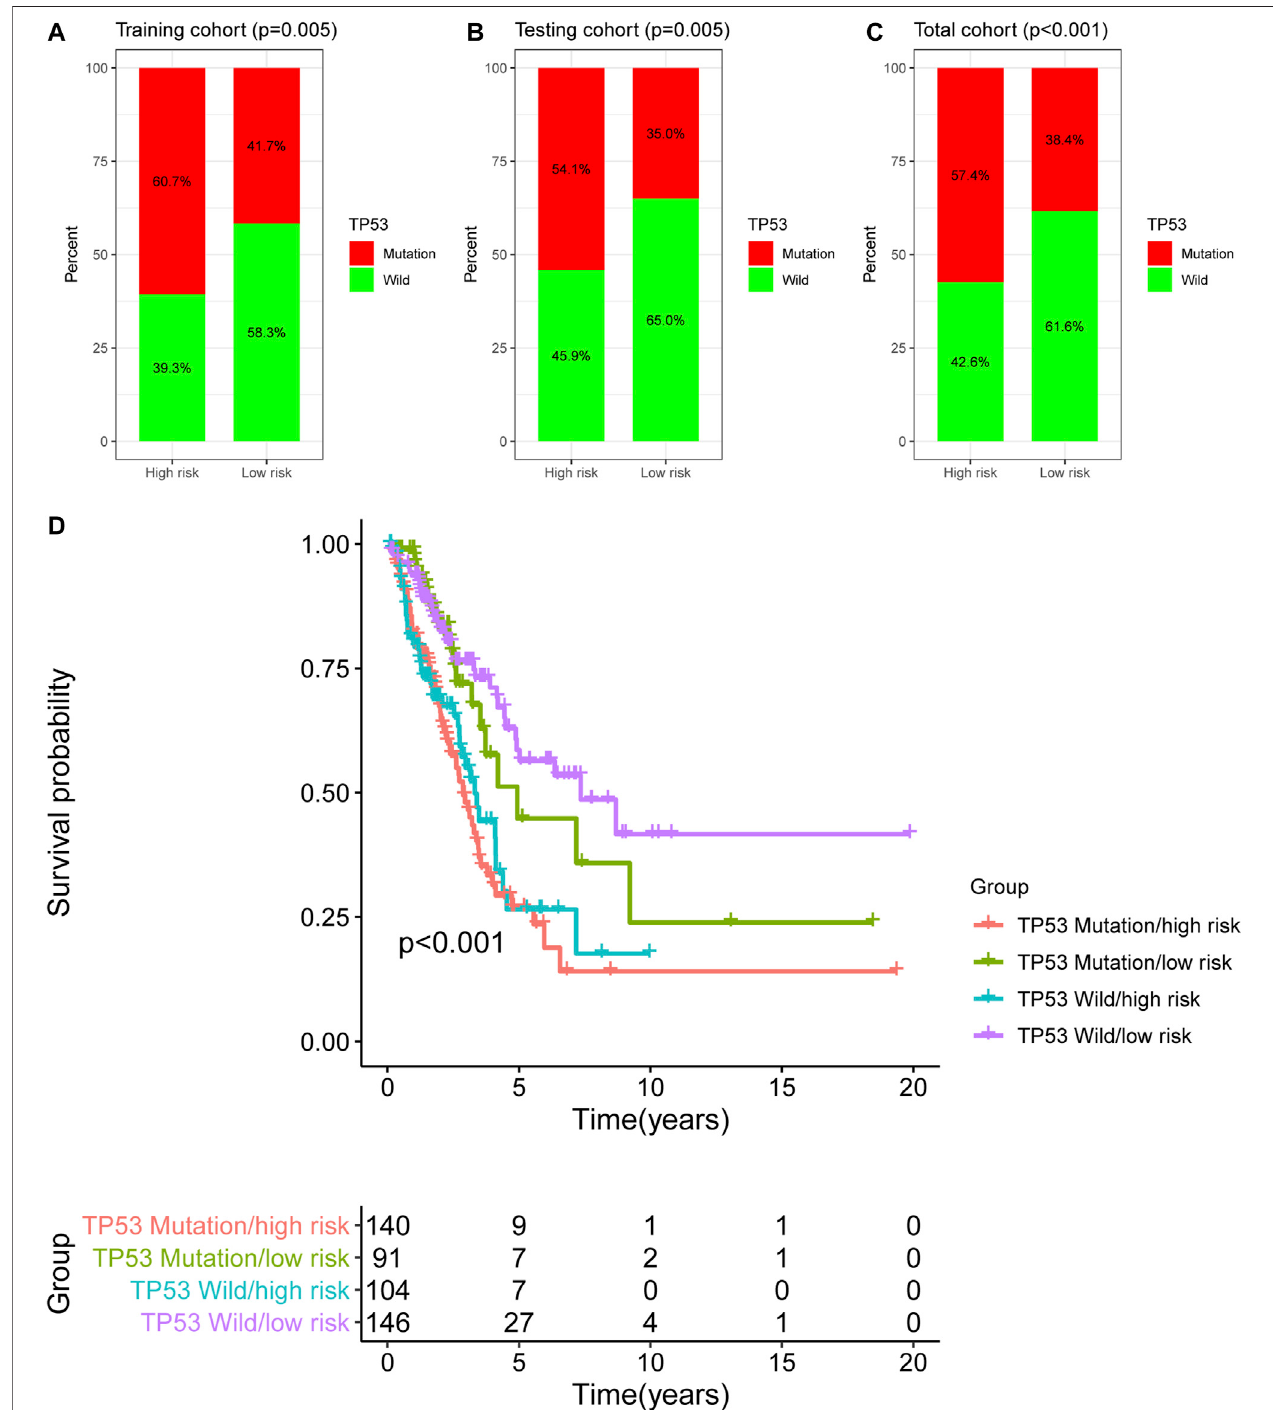
FIGURE6| ComparisonoftheGI-lncRNA-basedmodelandTP53statusforthepredictionofOSinLUAC.ComparisonofTP53mutationstatusbetweenthehigh- risk group and low-risk group strati fi ed by the risk scores of the GI-lncRNA-based model in (A) the training cohort, (B) the testing cohort, and (C) the total cohort; (D) Kaplan – Meier analyses of LUAC patients in the following four groups strati fi ed by the TP53 mutation status and risk score of the GI-lncRNA-based model: TP53 Wild/ high risk group, TP53 Wild/low risk group, TP53 Mutation/high risk group, and TP53 Mutation/low risk group.